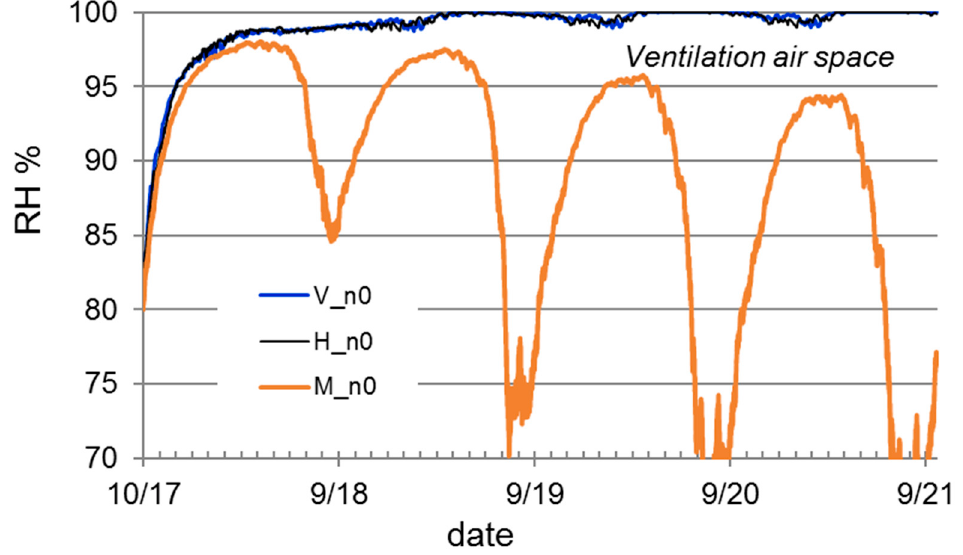
Figure 9. Brick wall, no ventilation, normal dry initial conditions (80% relative humidity (RH)). The relative humidity in the ventilation air space in three different climates during the four-year simulation period.